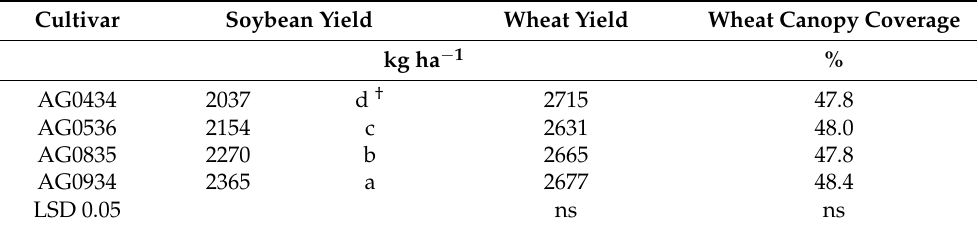
Table 7. Mean soybean yield, wheat yield, and wheat canopy coverage readings for four soybean cultivars averaged across four environments in Fargo, ND, USA, from 2016, 2017, and 2018.